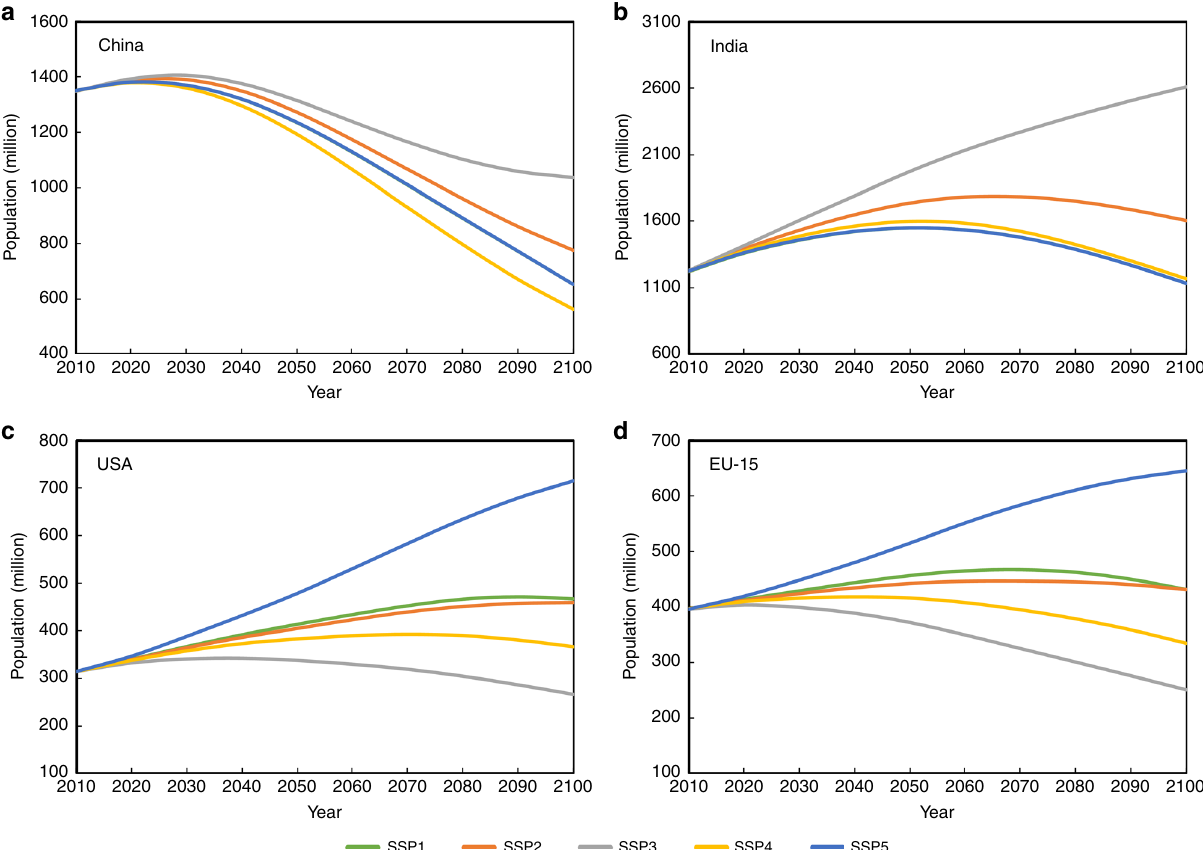
Fig. 6 Population projections in the representative regions facing the pressure of urban population decline from 2010 – 2100 under the SSPs. In China ( a ) and India ( b ), the population projections for the SSP1 and SSP5 scenarios are so close that their curves appear to be completely overlapping. EU-15 represents the European Union member states that joined prior to 2004, including Austria, Belgium, Denmark, Finland, France, Germany, Greece,